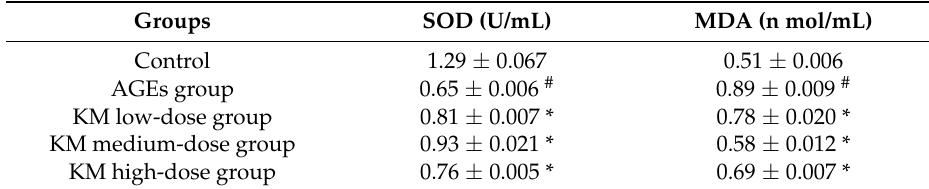
Table 1. Effects of KM treatment on AGE-induced MDA and SOD content in GMCs. Table1. Effects of KM treatment on AGE-induced MDA and SOD content in GMCs.